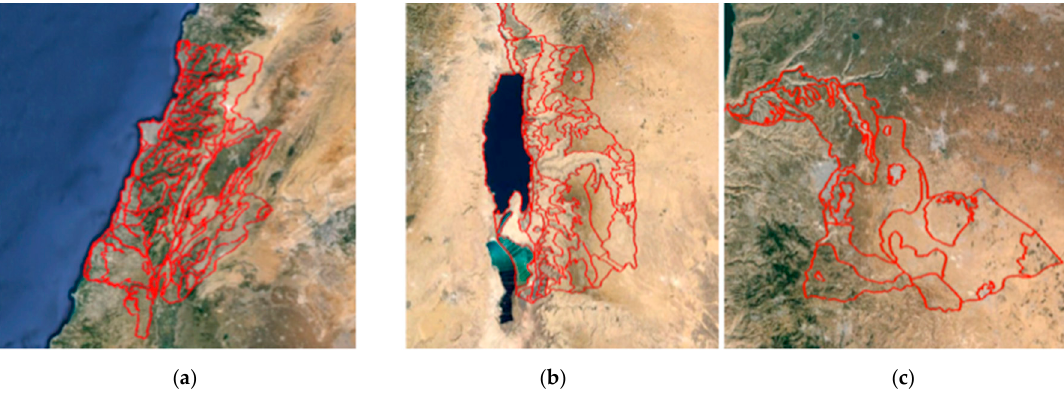
Figure 1. Risk assessment model study areas in the partner countries. ( a ) Lebanon Area: 4747 km 2 ; ( b ) Jordan—Mujib Area: 6790 km 2 ; ( c ) Jordan—Al-Yarmuk Area: 3800 km 2 .